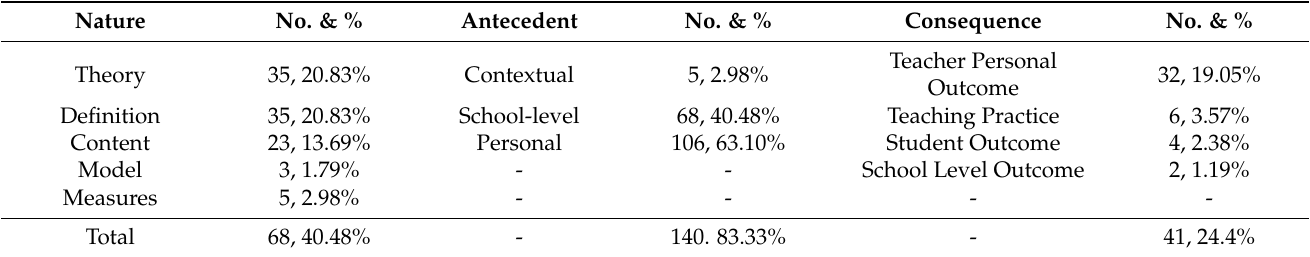
Table 2. Volume of Publications by Themes during